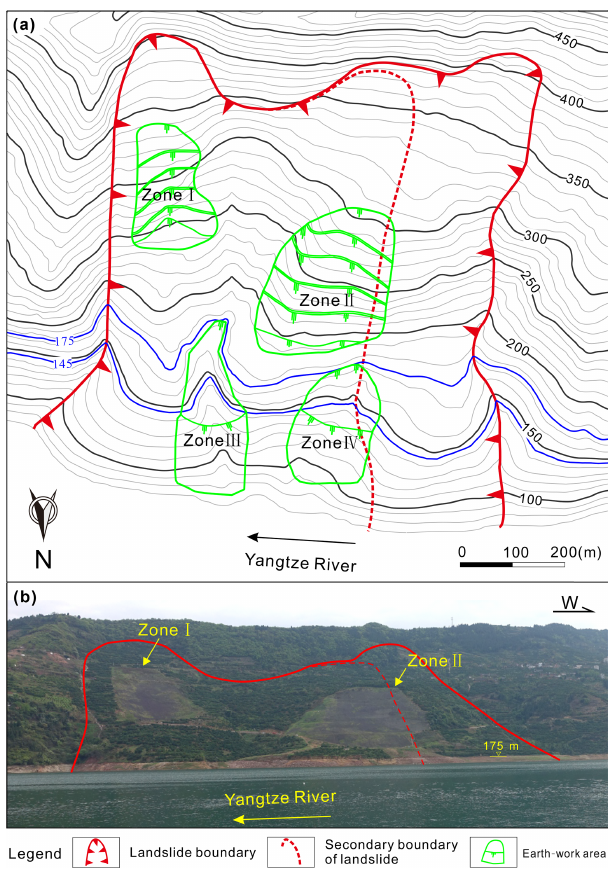
Figure 18. Topography of Shuping landslide before (a) and after (b) engineering treatment, which involved the transfer of earth from Zones I and II to Zones III and